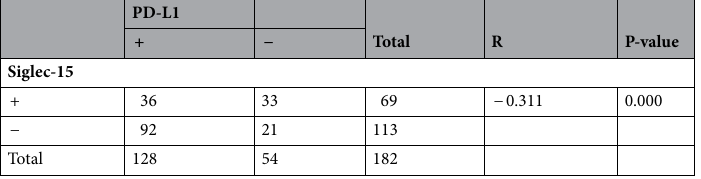
Table 2. The association between Siglec-15 and PD-L1 expression. Siglec-15 Sialic acid-binding immunoglobulin-like lectin 15, PD-L1 programmed cell death-Ligand